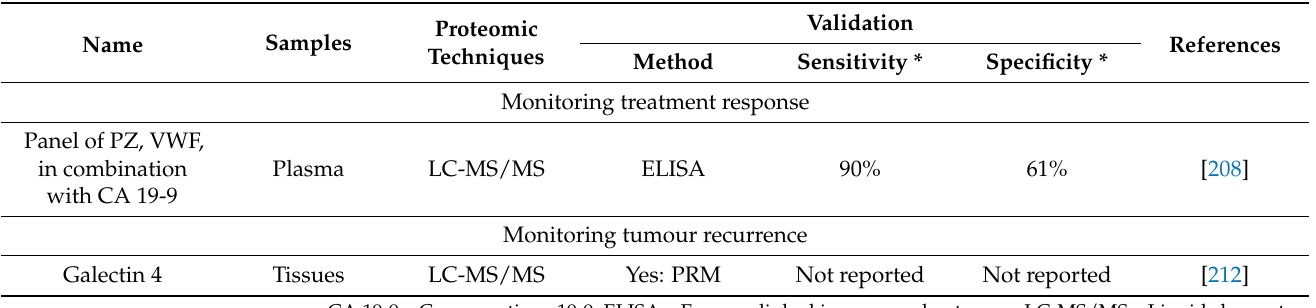
Table 4. Recently identified biomarker for monitoring treatment response and tumour recurrence of PDAC patients using proteomics